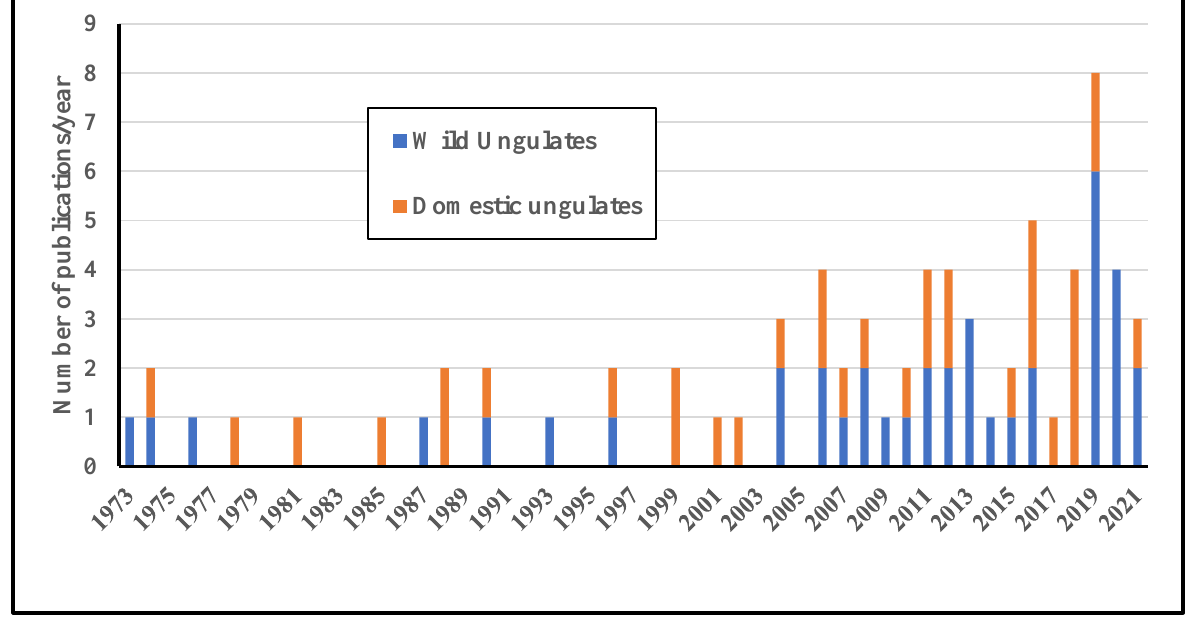
Figure 1. Number of publications per year ( n = 73, including review papers) focusing on the impact of wild and domestic (livestock) ungulates on reptile species based on the selected publications of the search.